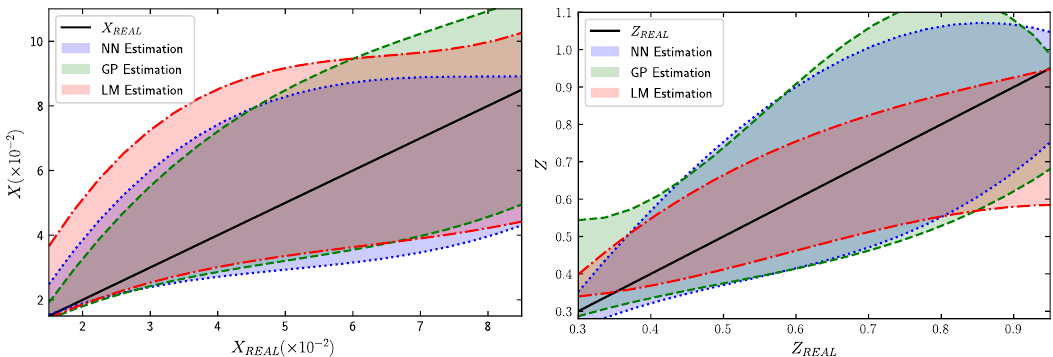
Figure 18: Correlation plots for X = x (left) and X = z (right). We defined the 1 error bands following the strategy mentioned in App. A, and present the results for the neural network (NN, blue), Gaussian process (GP, green) and the linear method (LM, red)